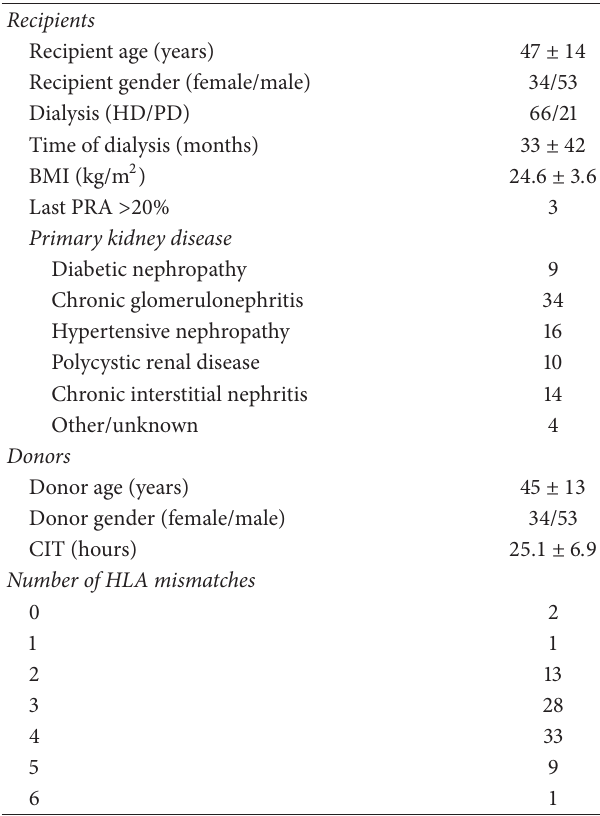
Table 1: Donor and recipient characteristics (mean ± SD or number of